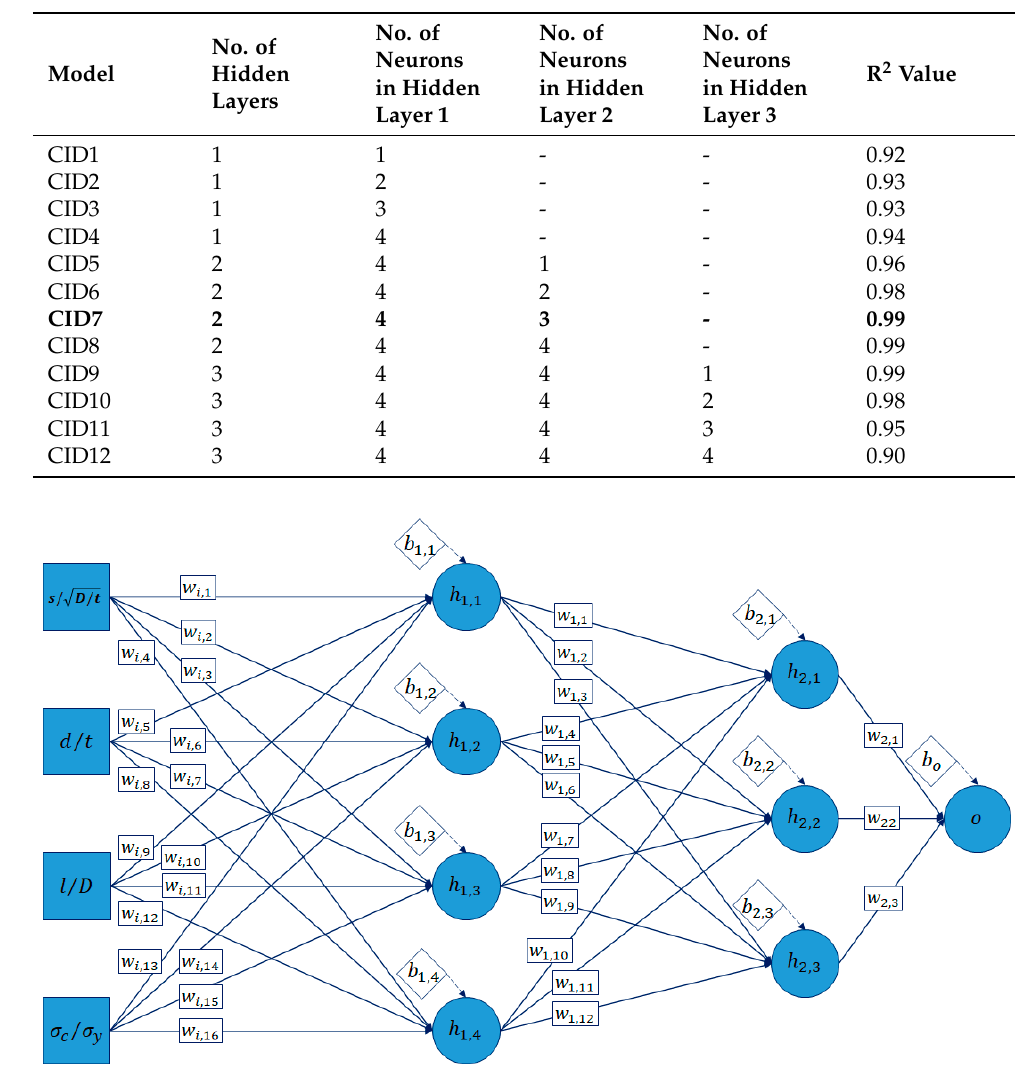
Table 11. Coefficient of determinant of the developed ANN models.